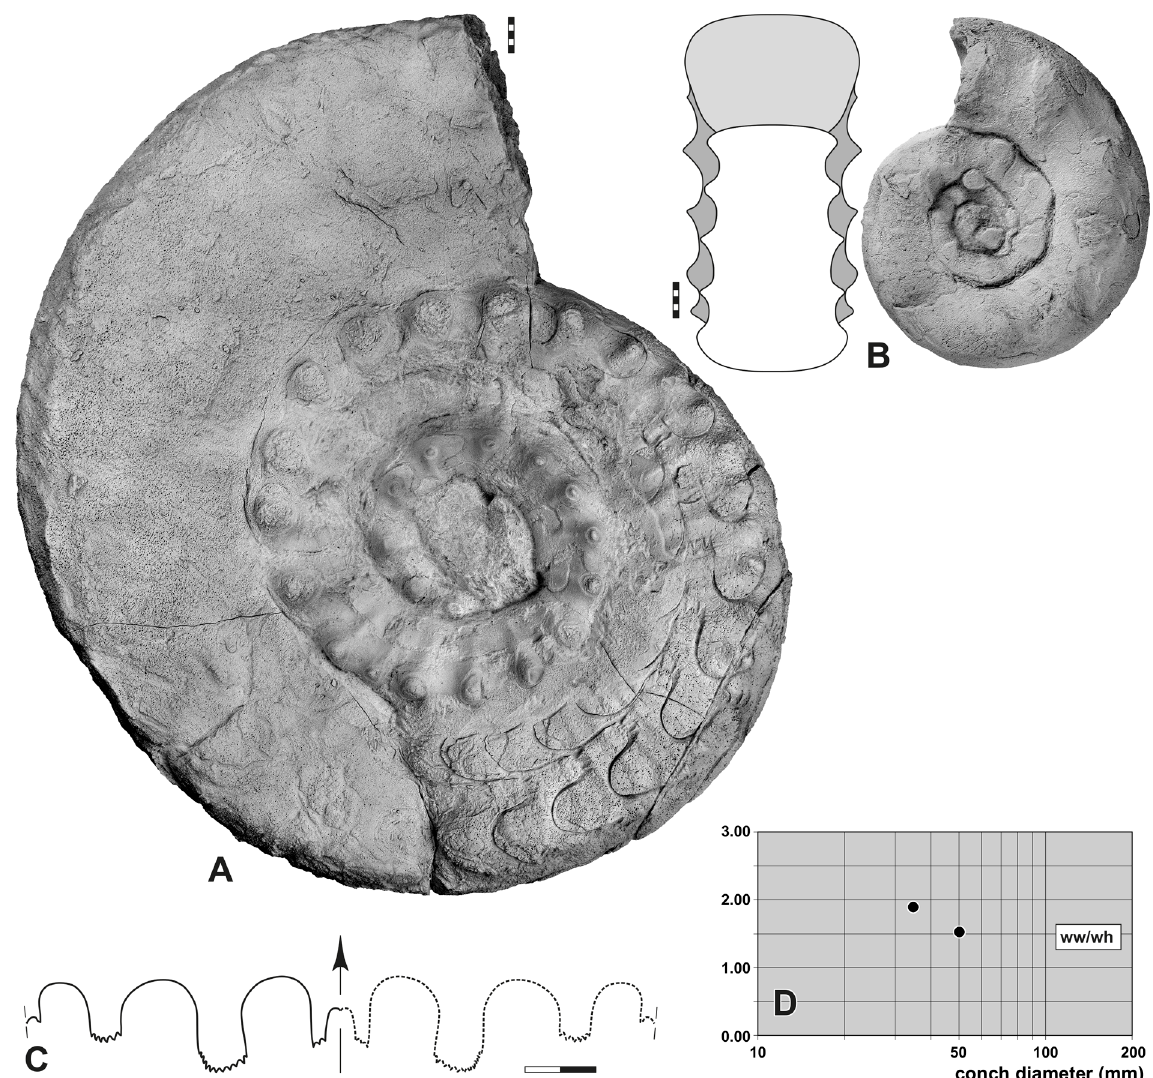
Fig. 23. Dzhulfites brevisellatus Korn & Hairapetian sp. nov. A–B . Lateral and dorsal views. A . Paratype MB.C.29746, float. B . Holotype MB.C.29748, section H, -5.70 m. C . Suture line, holotype MB.C.29748, at 21.0 mm ww, 13.5 mm wh. D . Whorl profile proportions. Abbreviations: see Material and methods. Scale bar units = 1 mm.